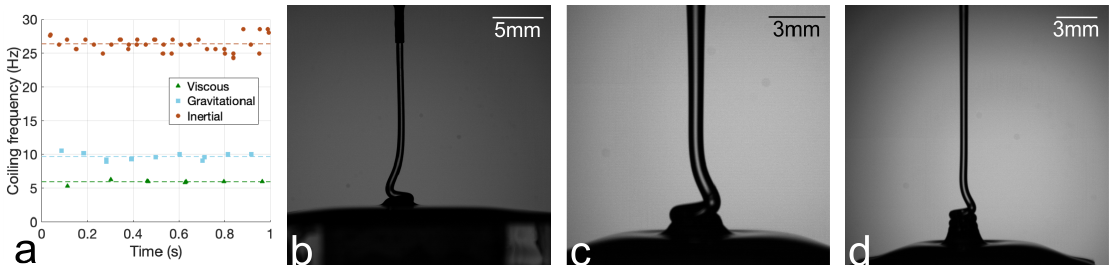
Figure 6. ( a ) Steady coiling with corresponding coiling frequency in various regimes. Instantaneous frequency measurements are represented by data points. Dashed lines denote the mean frequency throughout the steady coiling. ( b ) The viscous regime using honey at 0.2 mL · s − 1 from a fall height of